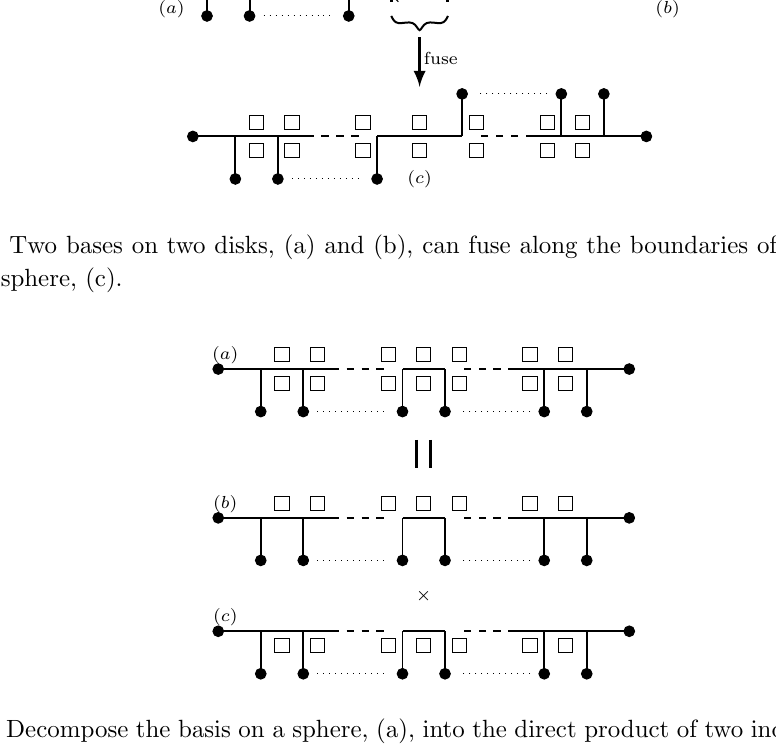
Figure 8 . Decompose the basis on a sphere, (a), into the direct product of two independent bases, (b) and (c). A represents a (cid:28) (cid:22) (cid:28) as (cid:15)